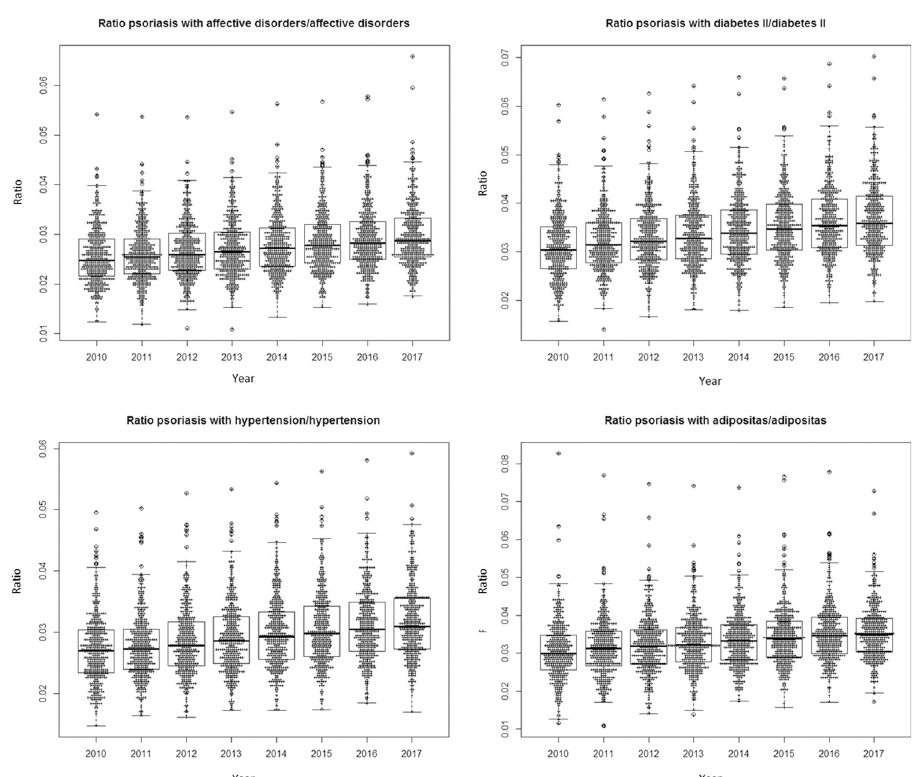
Fig 3. Bee swarm plots of ratios for psoriasis with comorbidity/comorbidity on county level. Each point represents one county.